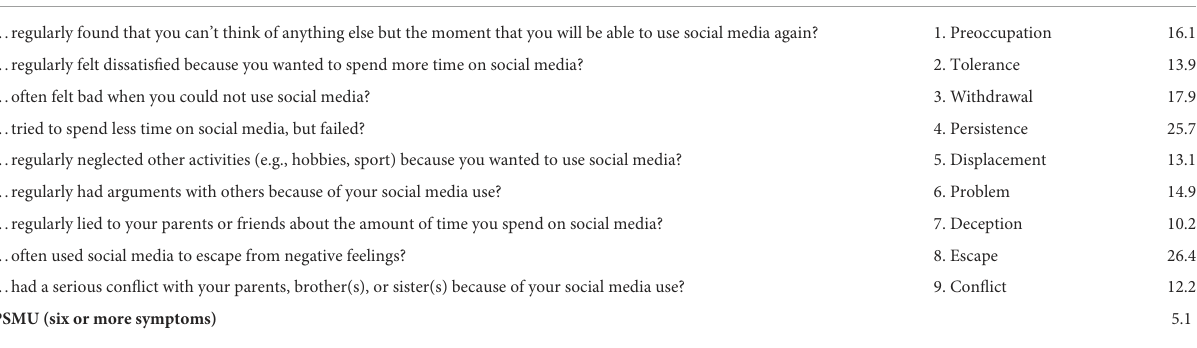
TABLE 1 Prevalence of PSMU symptoms. During the past year, have you...